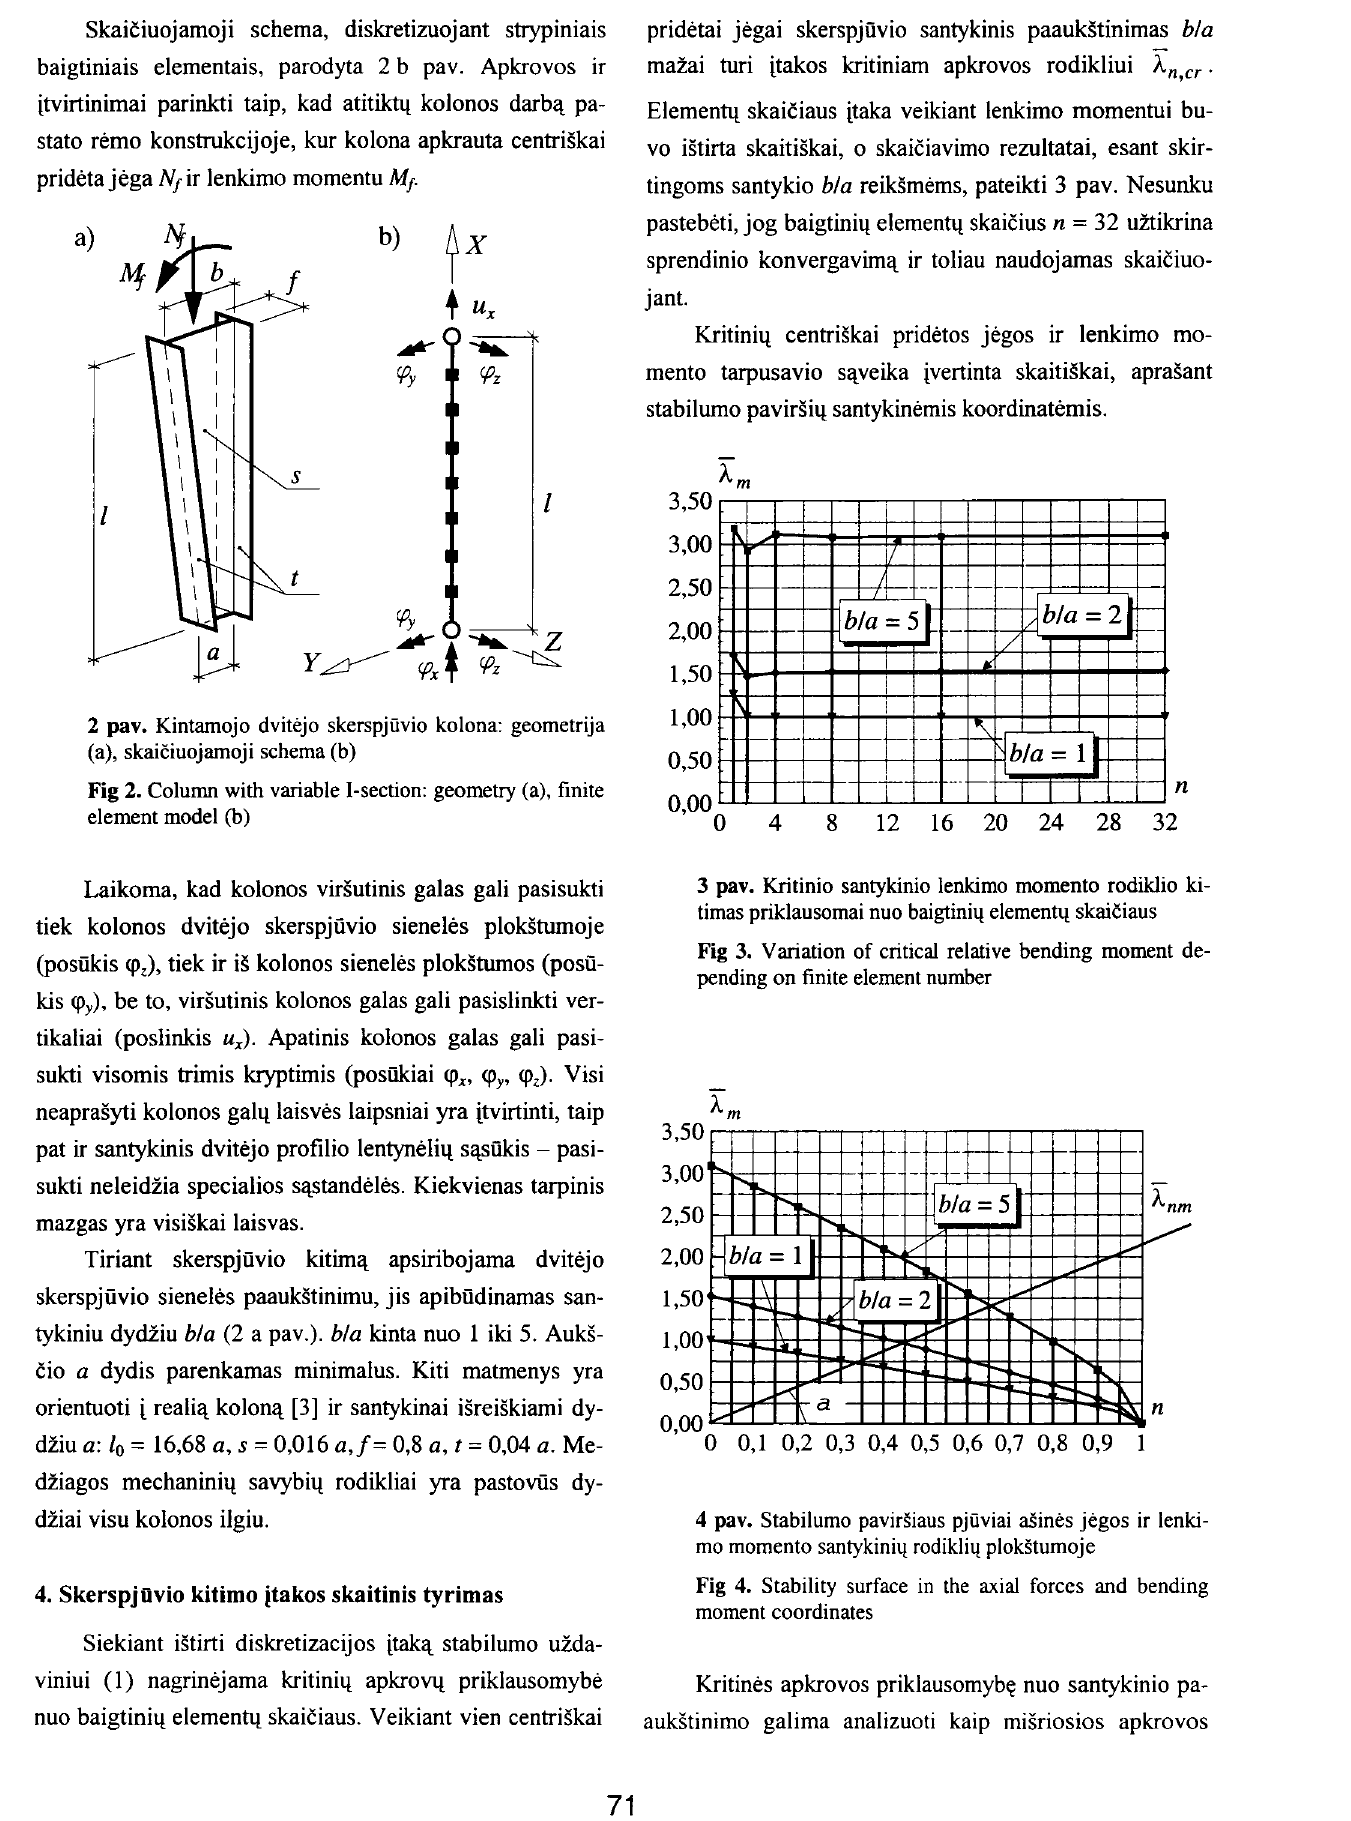
Fig 4. Stability surface in the axial forces and bending moment